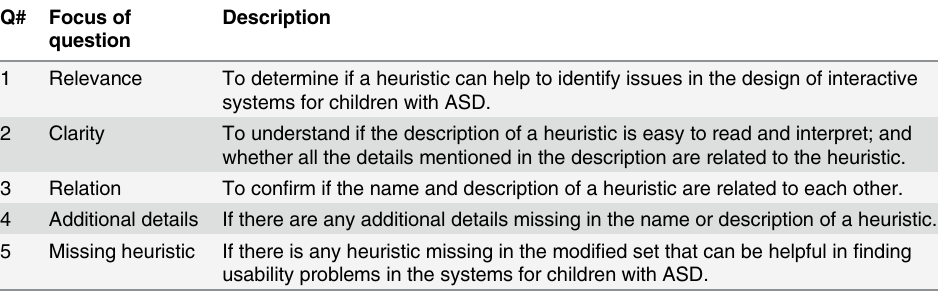
Table 5. Descriptions of